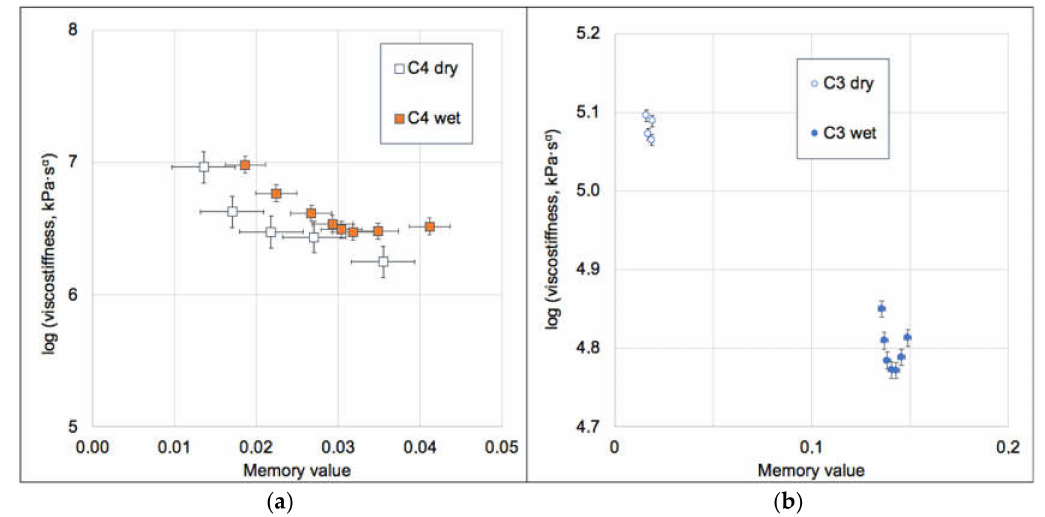
Figure 5. Dependence of the GAIN viscostiffness at 1 Hz vs. their memory values for C4 ( a ) and C3 ( b ). Error bars represent standard error. Note significant differences of memory value between wet and dry C3 scaffolds, but very close values for